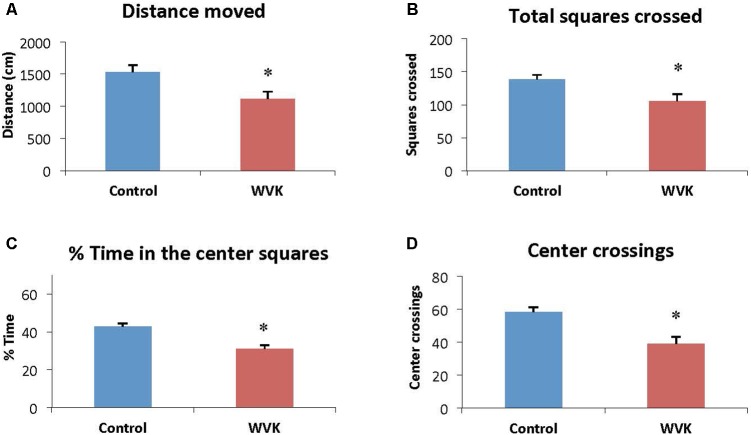
Effect of WVK treatment on locomotor activity and exploratory behavior in the open field. Figures show (A) the total distance moved; (B) the total number of squares crossed; (C) the mean % time spent in center squares; (D) the total number of center crossings. Values are mean ± SEM, n = 8–13 rats per group. Data were analyzed by Student’s unpaired t-test. Statistically different between C and WVK groups, ∗p < 0.05.